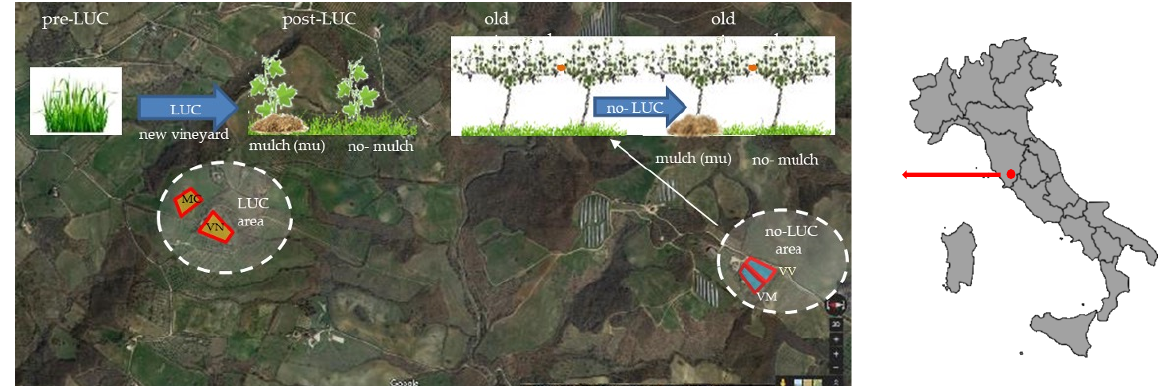
Figure 2. Two study areas (satellite image source: Google 2019): the LUC area (5100 m 2 , Coord. X: 42.639210, Y: 11.539317) and no-LUC area (8200 m 2 ; coord. X: 42.619682, Y: 11.537605) delineated by the dotted white circles and 4 different plots (VV area: 4200 m 2 ; VM area: 4000 m 2 ; VN area: 3000 m 2 ; MC area: 2100 m 2 ) delineated by the red boxes. The schematic representation of the experimental design describes the steps during the conversion process (LUC) from meadows to new vineyards by conservative practices in the upper soil layer (from 0 to 20 cm).